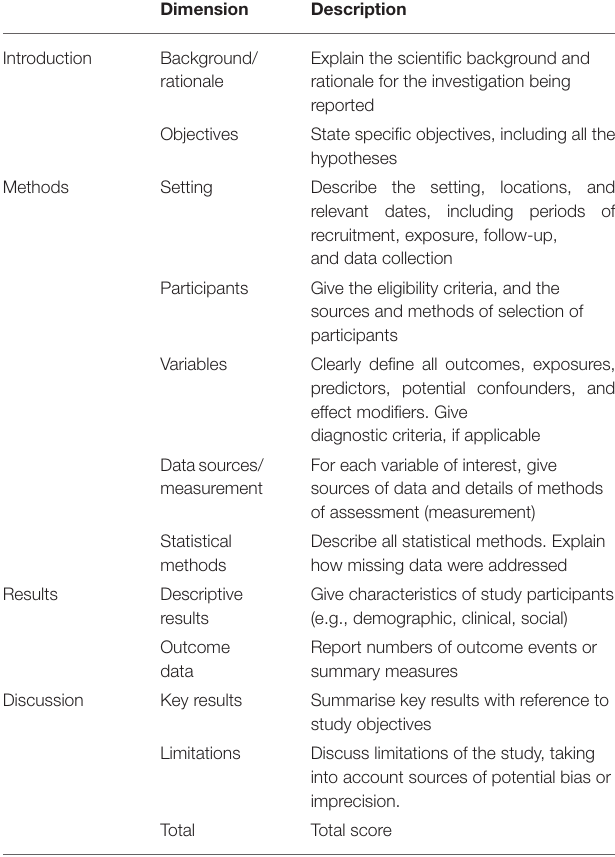
TABLE 1 | Complete list of keywords according to the PICO criteria. Population: